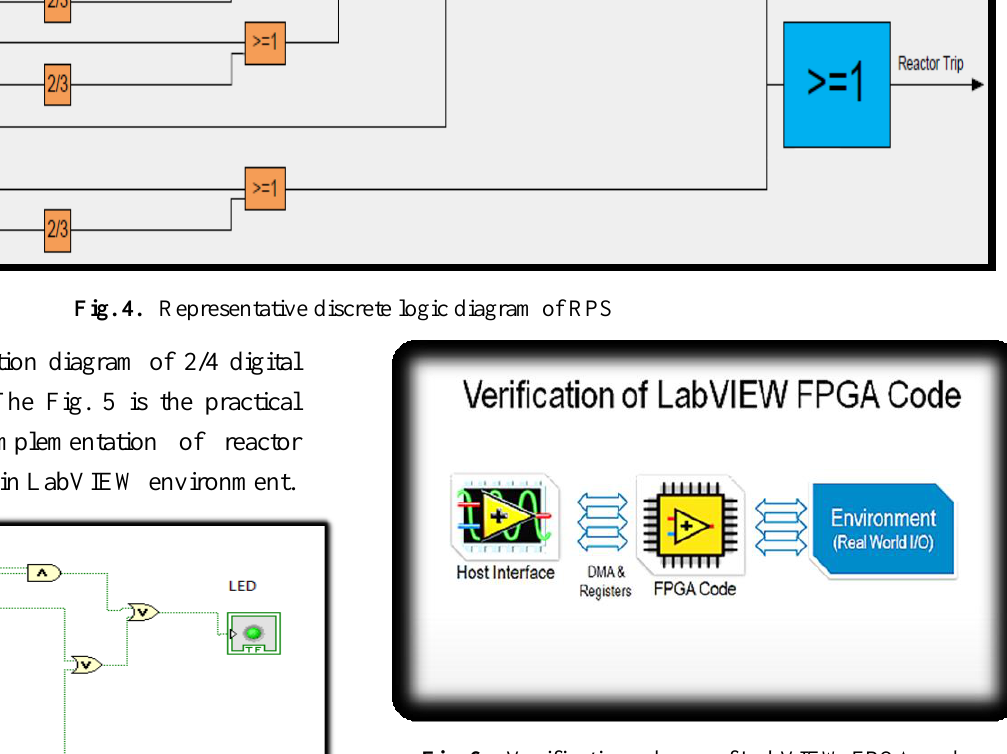
Fig. 6. Verification scheme of LabVIEW FPGA